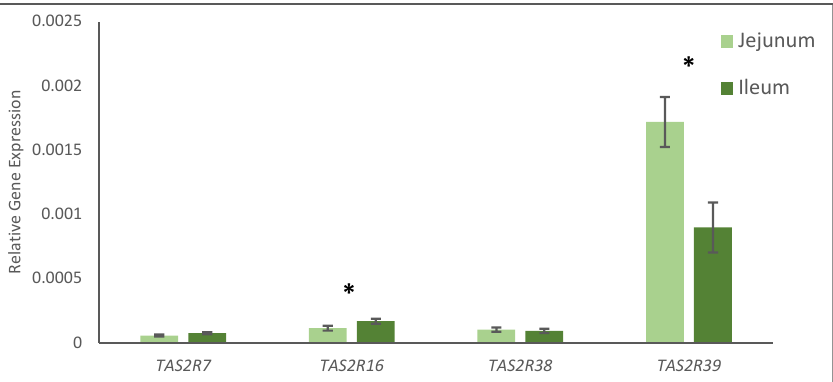
Figure 3. Gene expression of TAS2R on pigs fed the experimental diets analyzed by experimental diet. a, b means statistically different ( p < 0.05) within TAS2R16; A, B means statistically different ( p < 0.05) within TAS2R39.